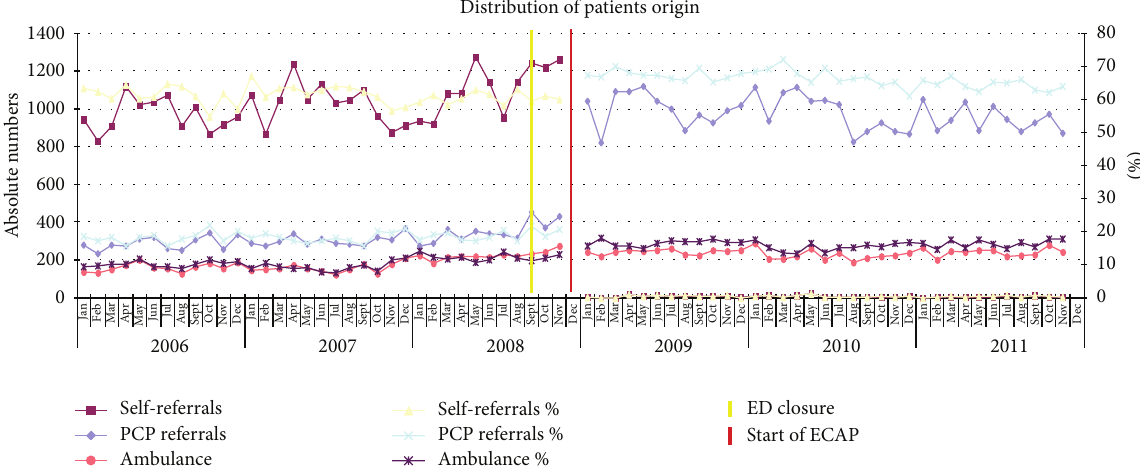
Figure 2: Distribution of patients origin. For visual reasons the percentage of revisits, referrals from outpatient clinics or other hospitals is not shown in this figure.